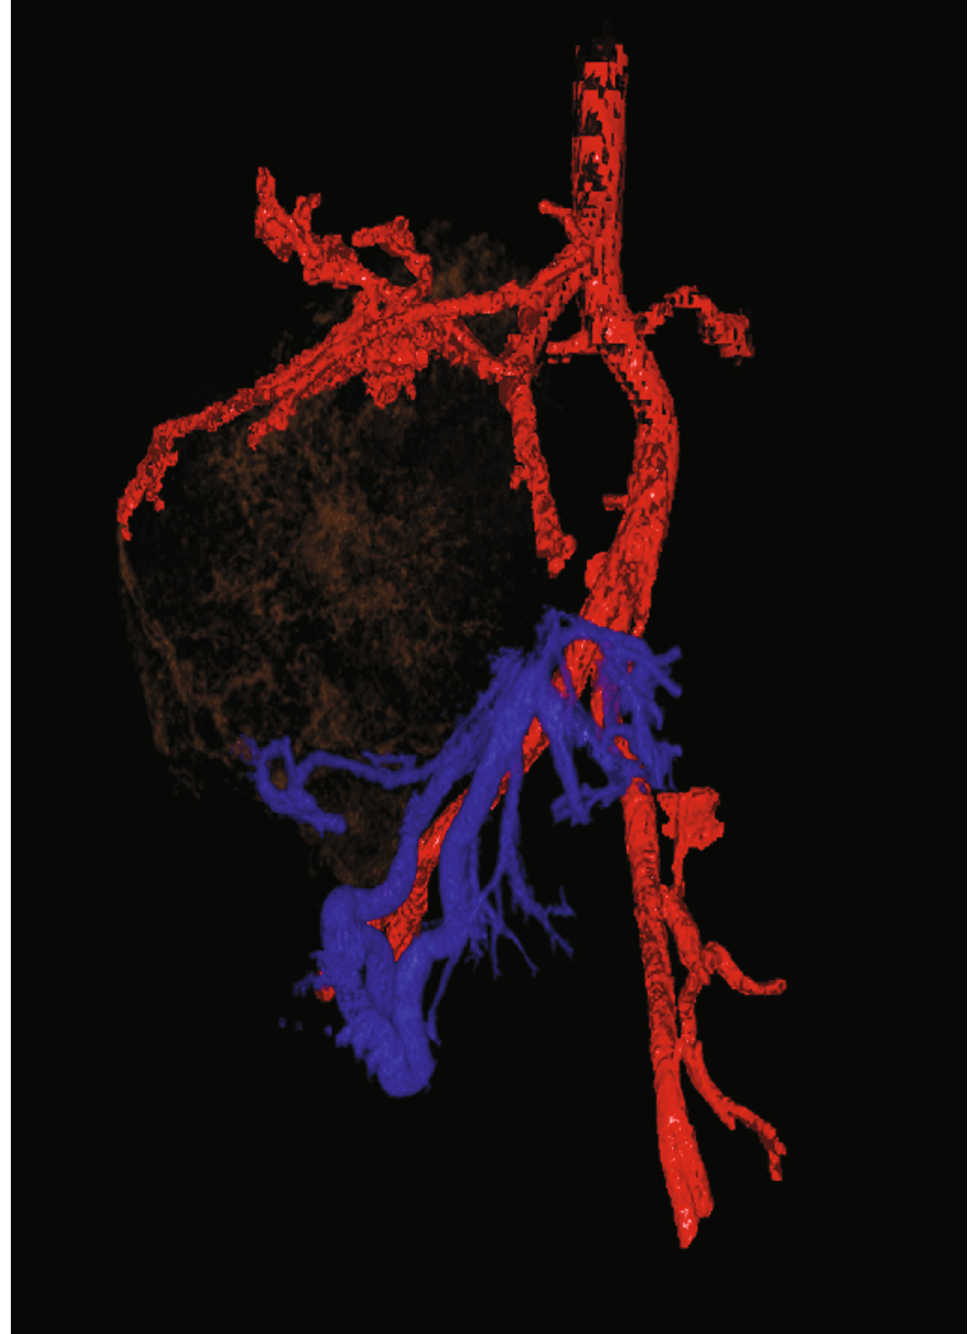
Figure 4: 3D reconstruction of the arterial and venous blood supply especially of the tumor mass